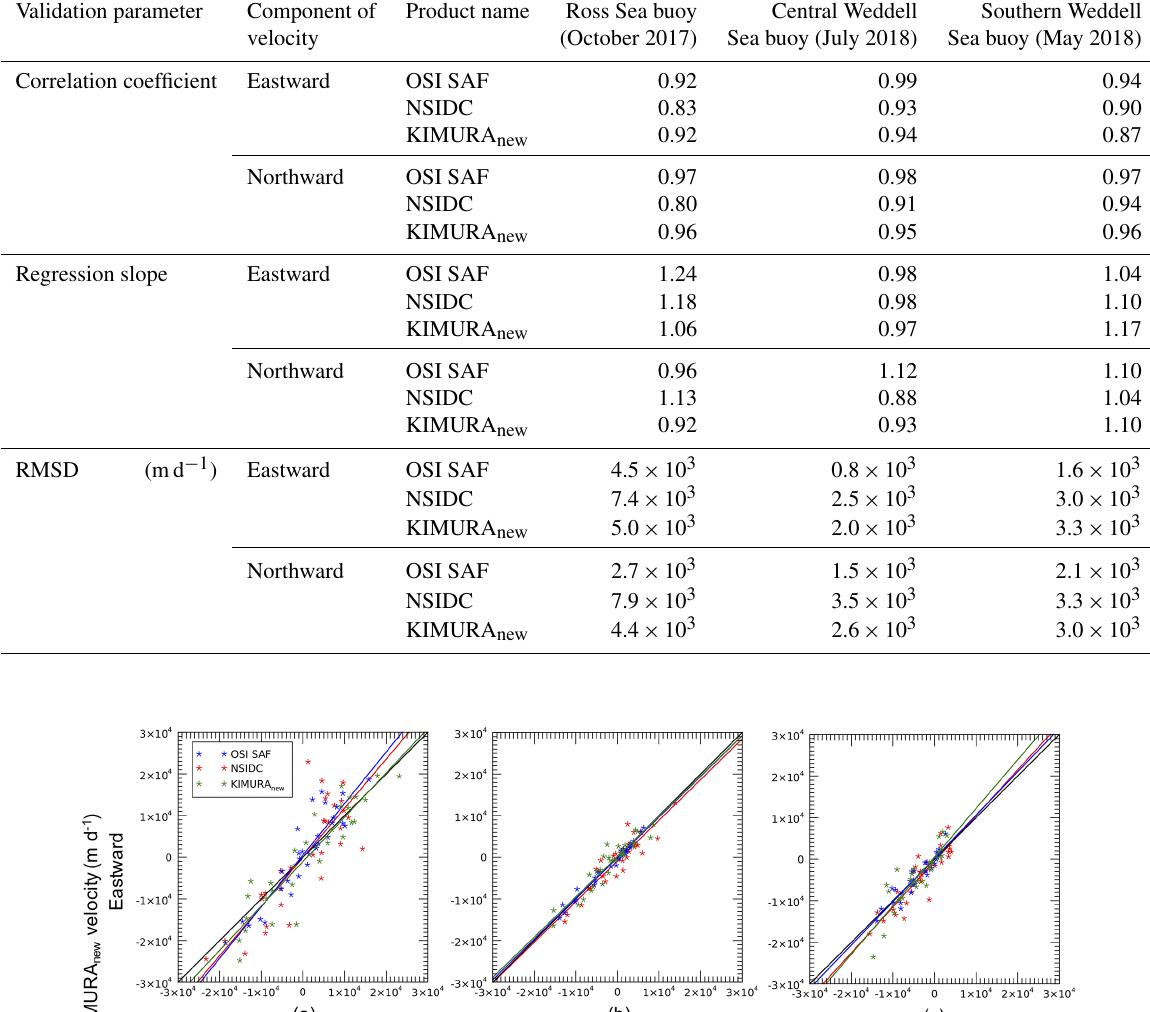
Table A1. Comparison of OSI SAF, NSIDC, and KIMURA new combined sea ice velocities against buoy-derived velocities. Validation parameter